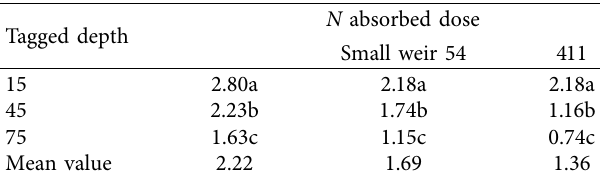
Table 2: Nitrogen uptake and utilization. Tagged